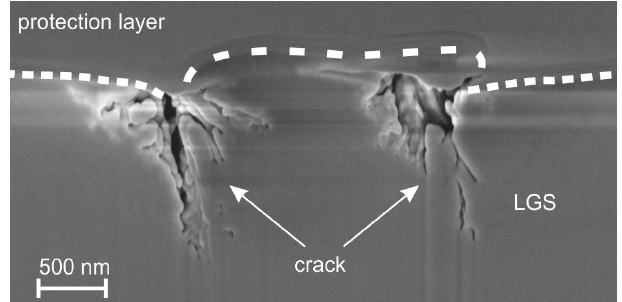
Figure 4. In-lens SEM image of a crack in the 10 + 48 h heated LGS substrate. The dashed line serves as guide to the eye for the interface between LGS substrate and protection layer which was deposited for the FIB process.